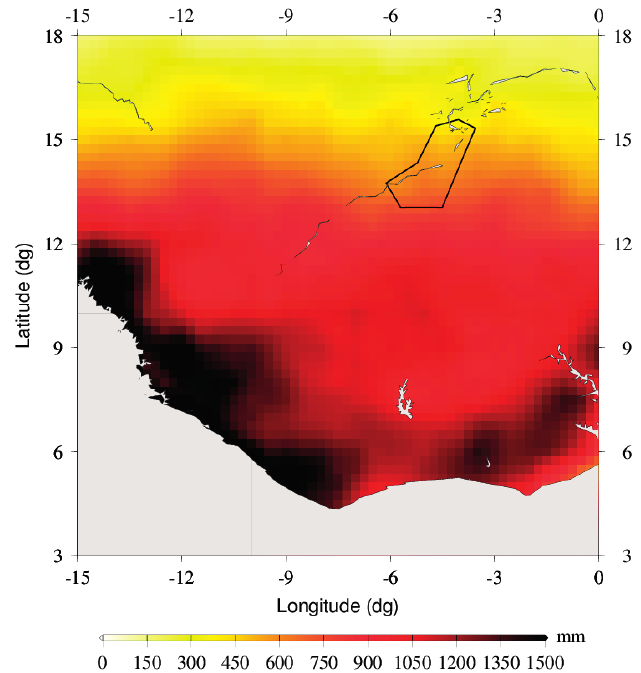
Figure 10. Map of mean annual precipitation over the Inner Niger Delta (IND) and upstream basins of Niger and Bani rivers, taken from Tropical Rainfall Measuring Mission (TRMM) 3B43 data from 2000 to 2013.